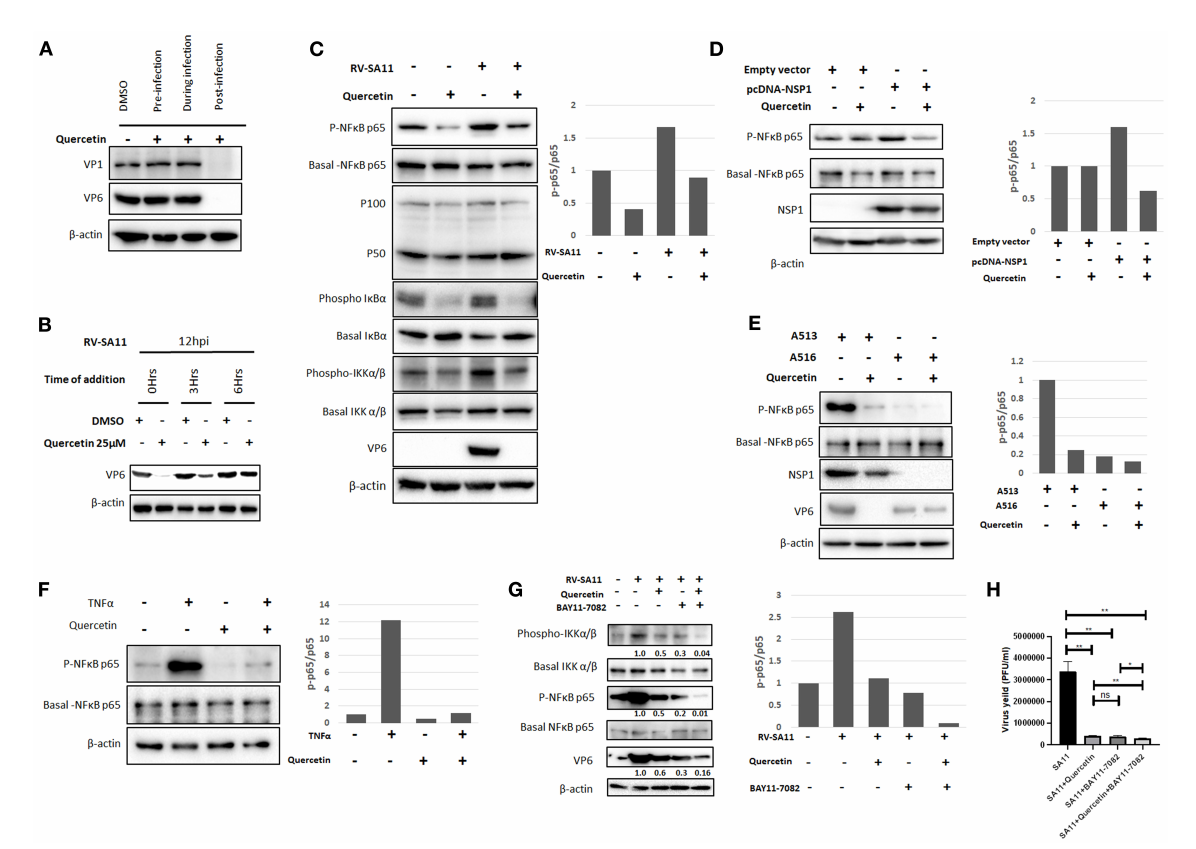
FIGURE4 Quercetin restricts rotavirus infection by inhibiting NF- κ B pathway. (A) RV-SA11 (MOI 3)-infected MA104 cells (12 hpi) were treated with DMSO or quercetin (50 µ M) 1h before adding the virus, during virus addition, and 1h after addition of the virus to assess the effect of quercetin on viral protein expression on the basis of time of addition. Western blot was performed to check VP1 and VP6 along with internal loading control β -actin. (B) SA11 (MOI 3)-infected MA104 cells (12 hpi) were treated with DMSO or quercetin (50 µ M) at 0, 3, and 6 hpi, respectively, to assess VP6 expression keeping β -actin as loading control. (C) Protein expression and phosphorylation status of chief players of NF- κ B signaling pathway such as NF- κ B p65, NF- κ B p50/p100, I κ B α , and IKK α / β were evaluated by SDS-PAGE. Cell lysates were prepared by mock-infected or RV-SA11 (MOI 3)-infected MA104 cells for 6 hpi in the presence of either DMSO or quercetin (50 µ M). The expression of VP6 and β -actin served the purpose of infection marker and internal loading control, respectively. The ratio of phospho p65 and basal p65 was plotted in bar graph. (D) pcDNA-NSP1 was transfected in MA104 cells to overexpress RV-NSP1 which triggers the activation of NF- κ B p65. Next, the transfected cells were either treated with DMSO or quercetin (50 µ M). Consequently, the cell lysates are subjected to Western blot to detect the expression of phospho and basal NF- κ B p65, NSP1, and internal loading control β -actin. Phospho p65 level was normalized against basal p65 and represented in bar graph. (E) MA104 cells are infected RV strain A5-13 (wild-type NSP1) and A5-16 (mutant NSP1), respectively, followed by administration of DMSO or 50 µ M quercetin. Cell lysates are run for SDS-PAGE for the detection of phospho and basal NF- κ B p65, NSP1, VP6 (infection marker), and β -actin (loading control). The ratio of phospho p65 and basal p65 was represented by bar graph. (F) TNF α (10nM) is administered to MA104 cells to induce NF- κ B signaling and also co-treated with quercetin (50 µ M) to check the effect of quercetin on TNF α -induced NF- κ B pathway. Western blot analysis was done to check expression and phosphorylation of NF- κ B p65, and β -actin was checked as internal loading control. Phospho p65 is normalized against basal p65 and plotted in bar graph. (G) BAY11-7082 (10 µ M) is added to RV-SA11 (MOI 3)-infected MA104 cells (6 hpi) either alone or co-treated with quercetin (10 µ M) to check VP6, NF- κ B, IKK α / β , and β -actin (loading control) protein levels by Western blot. (H) Plaque assay was performed to assess viral titer from SA11-infected MA104 cells treated with DMSO, quercetin (10 Mm), BAY11-7082 (10 µ M), and quercetin co-treated with BAY11-7082, respectively. Phospho p65 and basal p65 ratio is represented in bar graph. Each bar represents mean ± SD of three independent experiments (Unpaired student’s t-test, ns denotes p value not significant, * p < 0.05, ** p <